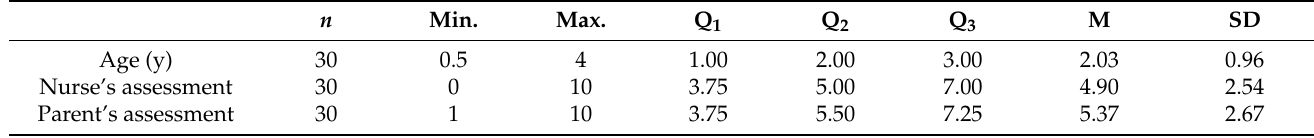
Table 5. FLACC pain scores as assessed by nurses and parents. Patients were <4 years of age.